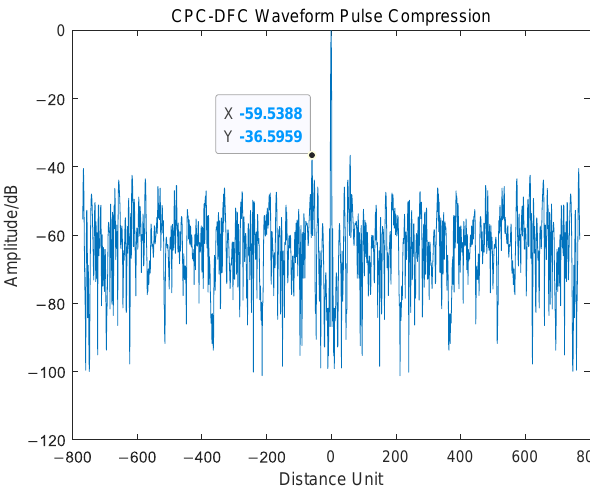
Figure 13. CPC -DFC Waveform Pulse Compression.